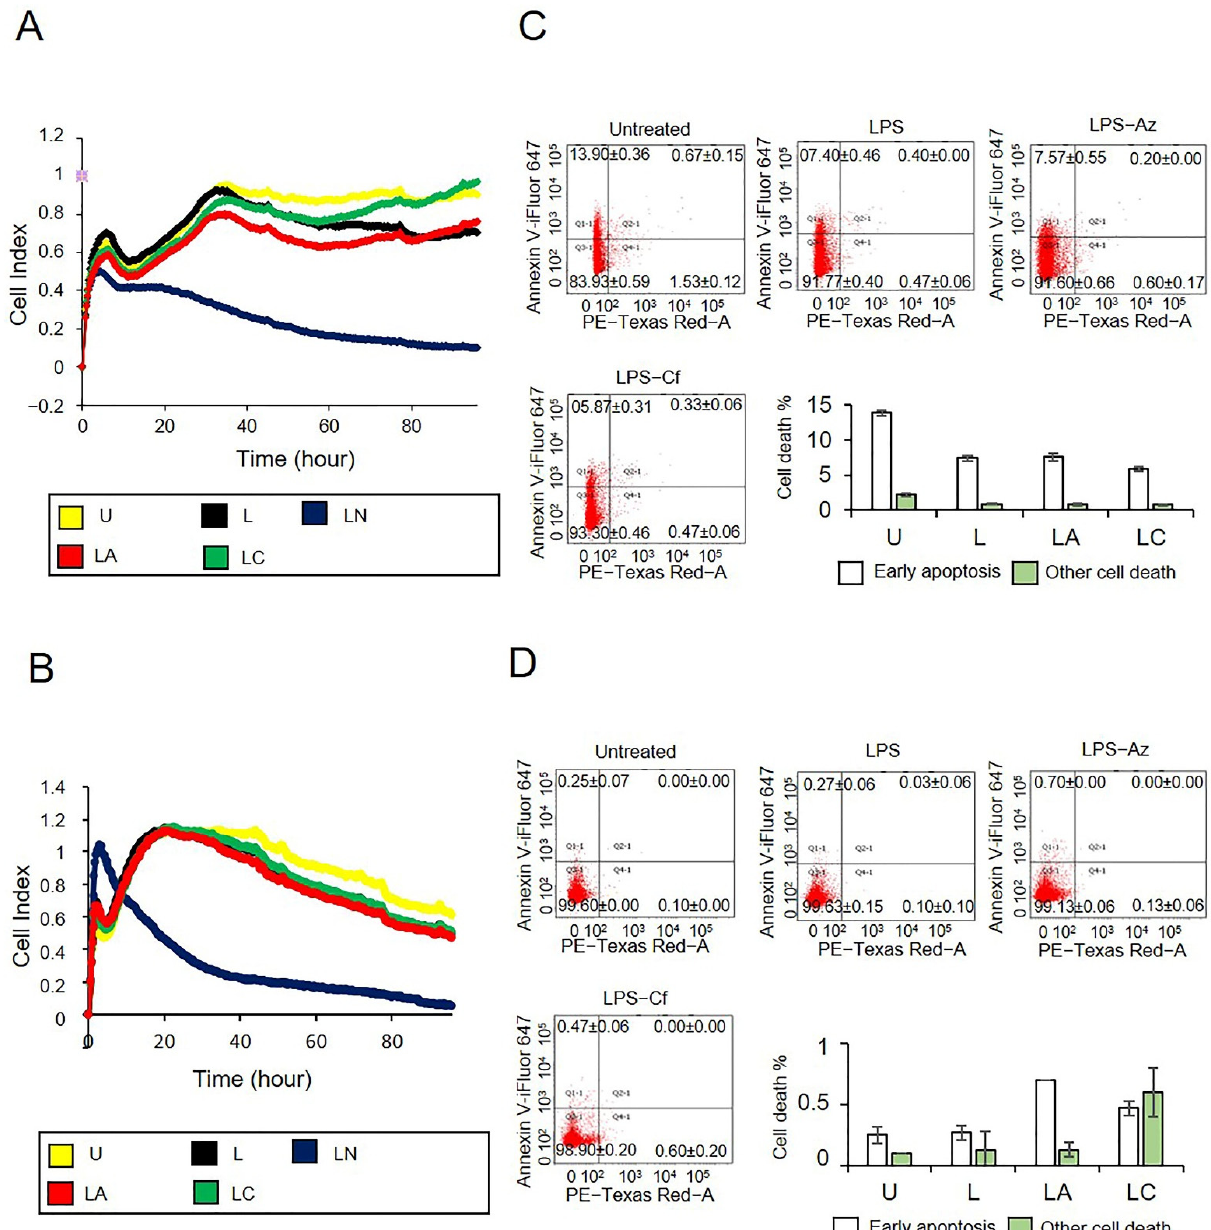
Figure 6. The effect of azithromycin and ceftriaxone induced activation of NLRP3 on proliferation and cell viability of A549 and PC3 cells. ( A ) The effect of LPS-azithromycin and LPS-ceftriaxone treatments on A549 cell proliferation; ( B ) PC3 cell proliferation; ( C ) A549 cell viability; and ( D ) PC3 cell viability. Adjusted p -values were calculated using Independent Samples Kruskal–Wallis